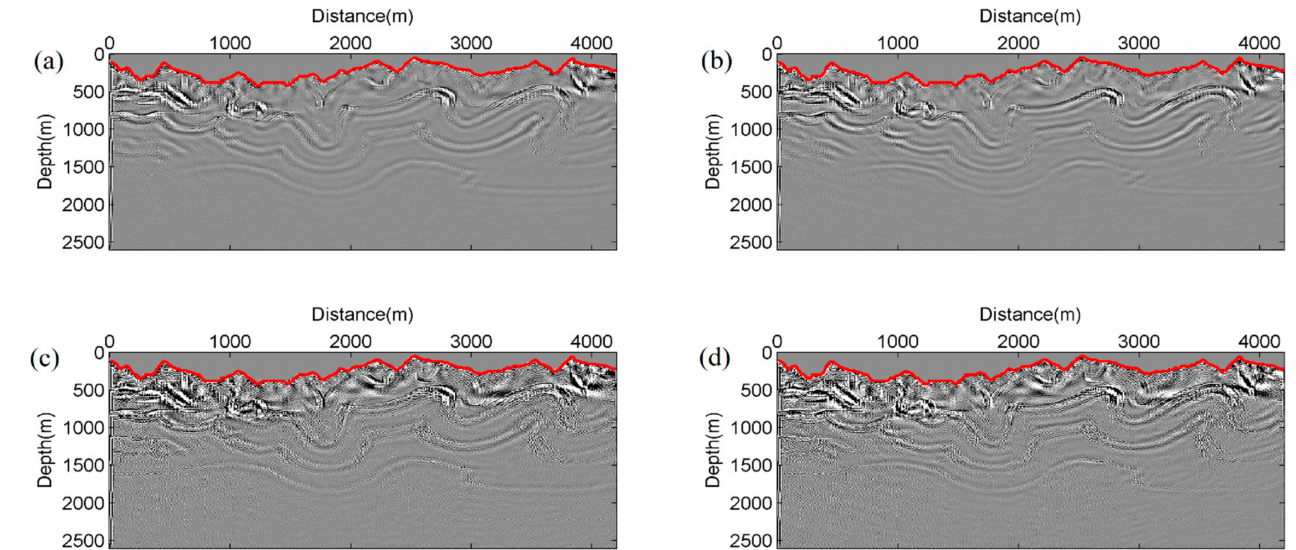
Figure 18. Migration images using different noisy data with the proposed method. The left panels are the PP-wave images, and the right panels are the PS-wave images. Incorrectly filled near-surface elastic parameters were also used. Panels ( a , b ) are the migration images using the common-shot gathers with SNR 1 dB, and panels ( c , d ) are the migration images using the common-shot gathers with SNR 4 dB. The red line is the surface